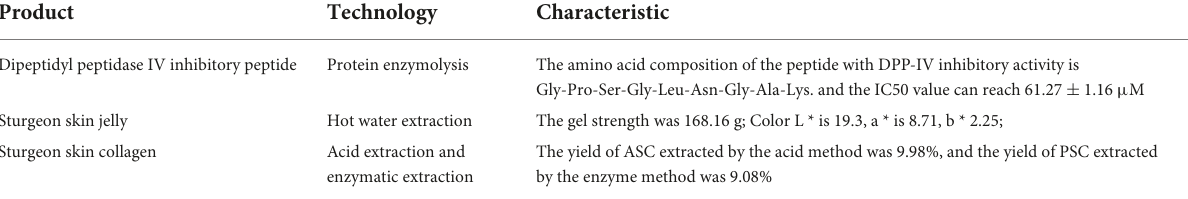
TABLE 3 Extraction methods and characteristics of byproducts from sturgeon skin (42, 44,